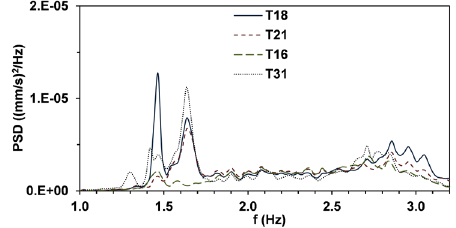
Figure 27. PSDs in tangential directions at T18, T2, T16 and T31.